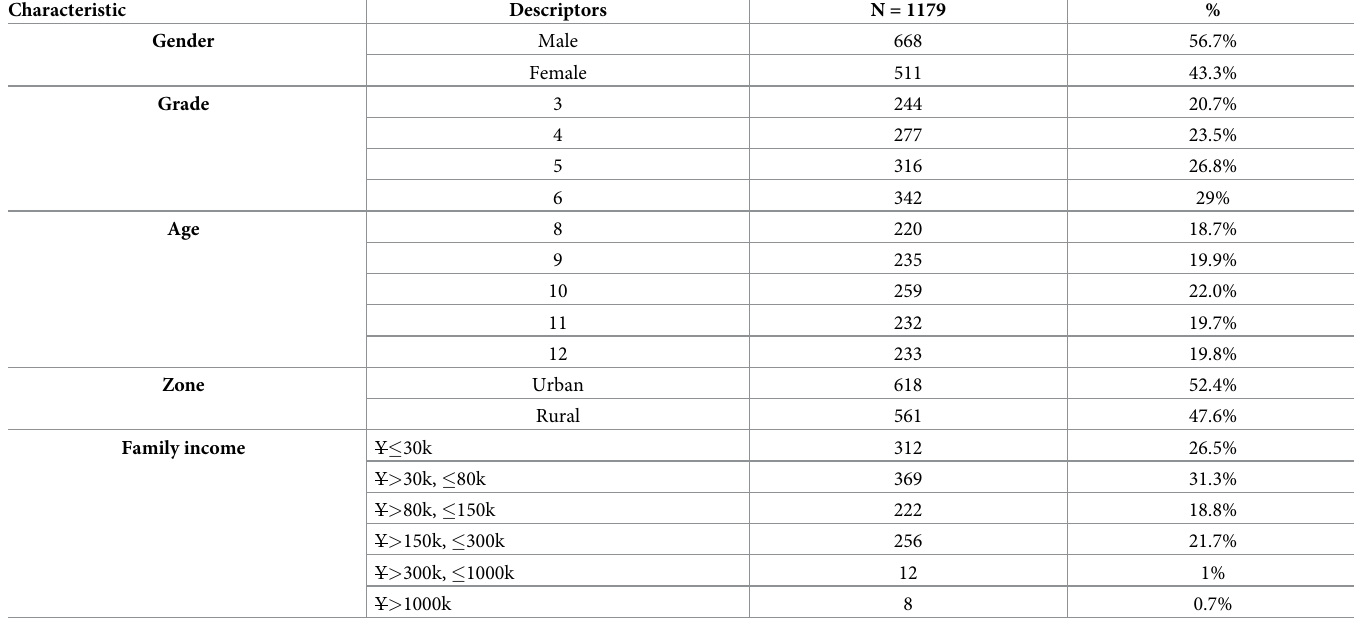
Table 2. Children’ demographic